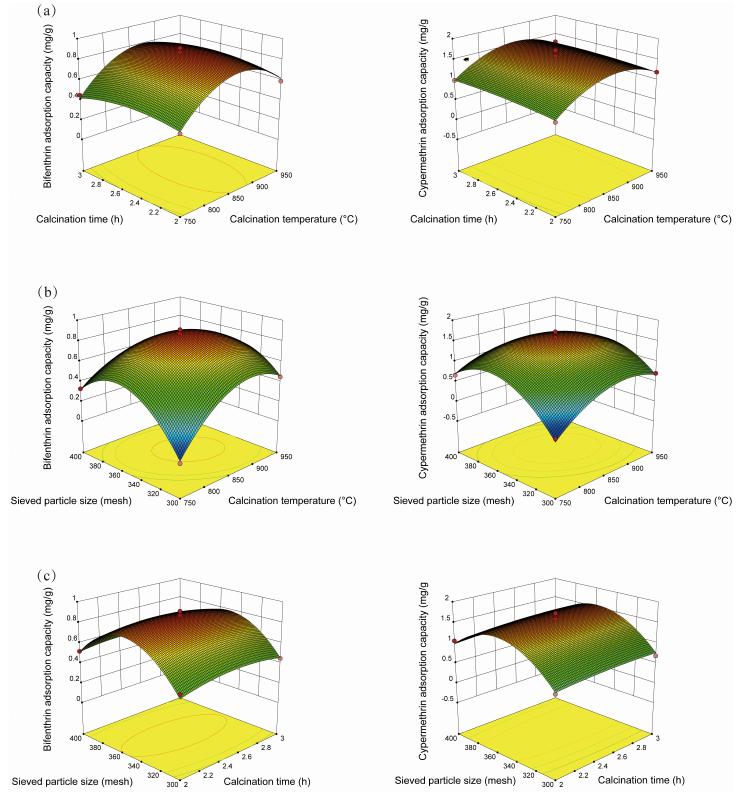
Figure 1. Response surface diagram for the combined effect of ( a ) calcination temperature and calcination time, ( b ) calcination temperature and sieved particle size, and ( c ) calcination time and sieved particle size on pyrethroid adsorption capacity.